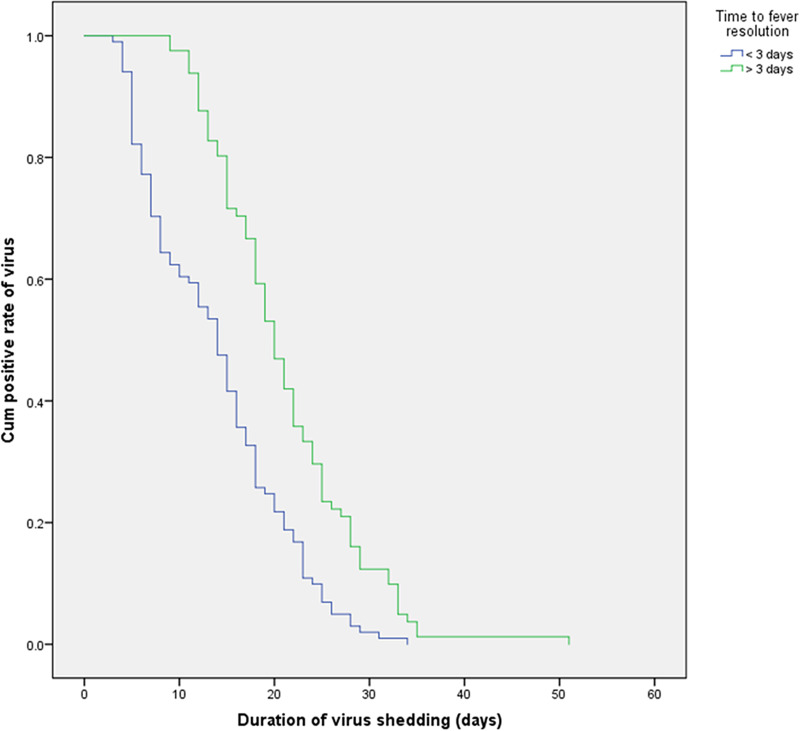
Kaplan–Meier plot for fever resolution time.